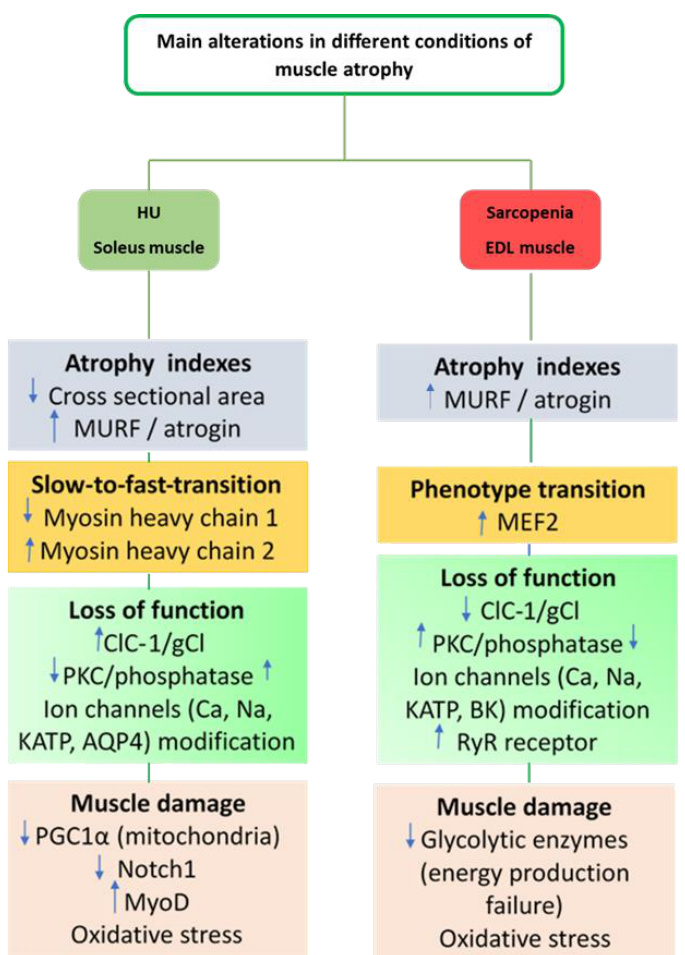
Figure 2. A brief description of the main mechanisms contributing to muscle atrophy during HU or aging in different muscle types. Soleus muscle as a slow-twitch muscle. Extensor digitorum longus (EDL) as a fast-twitch muscle. Arrows up indicate an increase and arrows down a decrease.